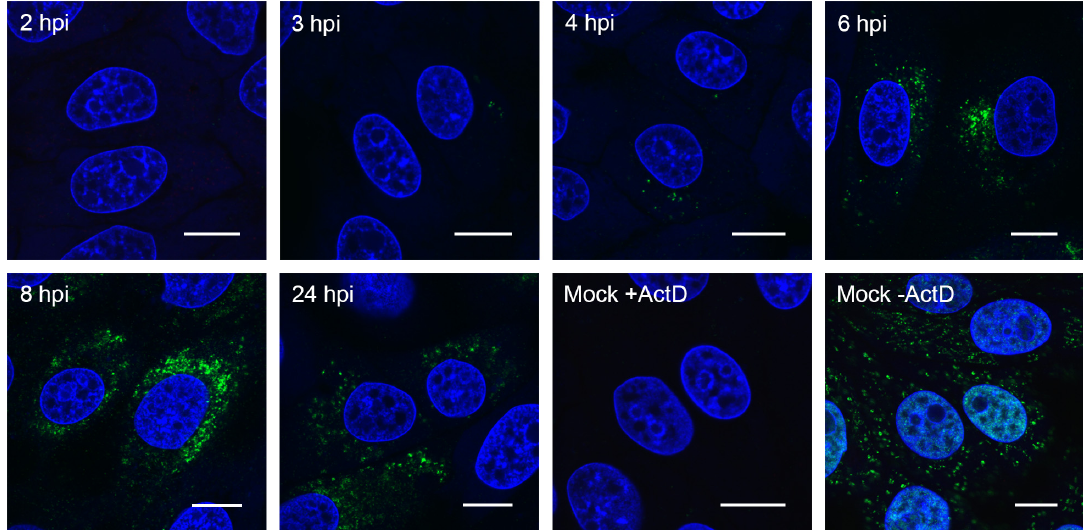
Figure 3. PDCoV RNA synthesis was detected from 3 hpi. LLC-PK1 cells were infected or mock-infected. Thirty minutes prior to the indicated fixation time, cells were incubated with 2 mM 5-Bromouridine (BrU) and 15 µ M actinomycin D (ActD). Mock cells were incubated with ( + ActD) and without ( − ActD) actinomycin D as indicated. Cells were fixed and RNA containing BrU were detected using an anti-BrdU antibody (green). Nuclei were stained with DAPI (blue), scale bar indicates 10 µ m. Images representative of three independent replicates.